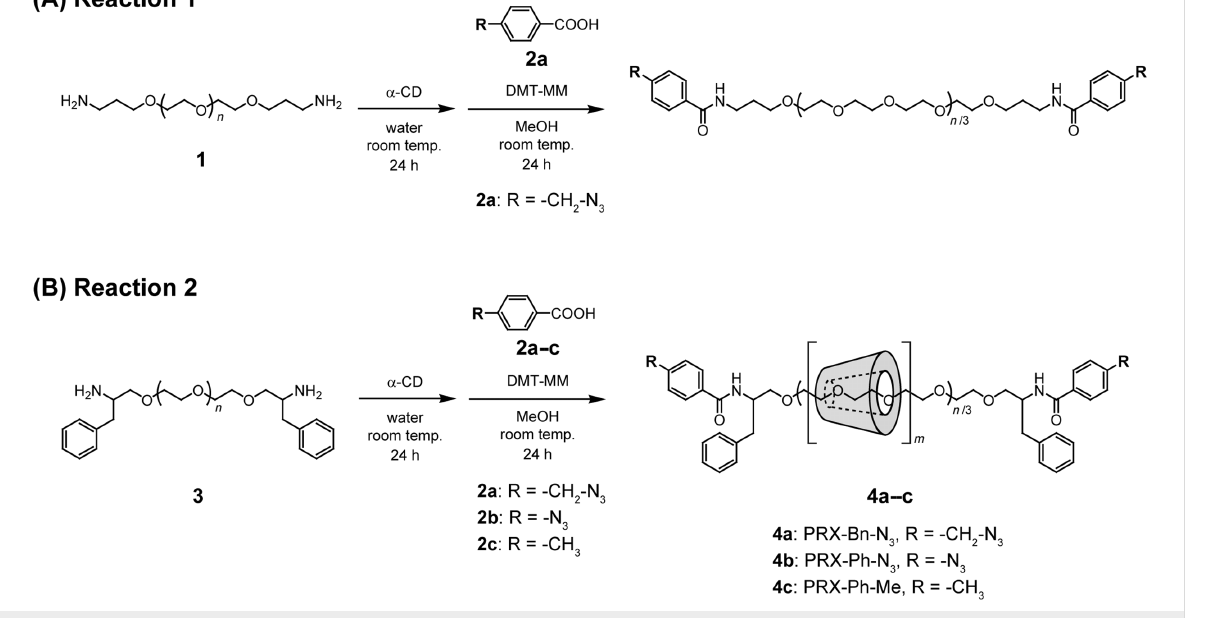
Next, to investigate whether other 4-substituted benzoic acids can be used as capping reagents for the preparation of the PEG- Ph-NH 2 / α -CD-based PRXs, the same capping reaction was demonstrated using 4-azidobenzoic acid ( 2b ) and 4-methylben- zoic acid ( 2c ). SEC charts of the resulting PRXs clearly